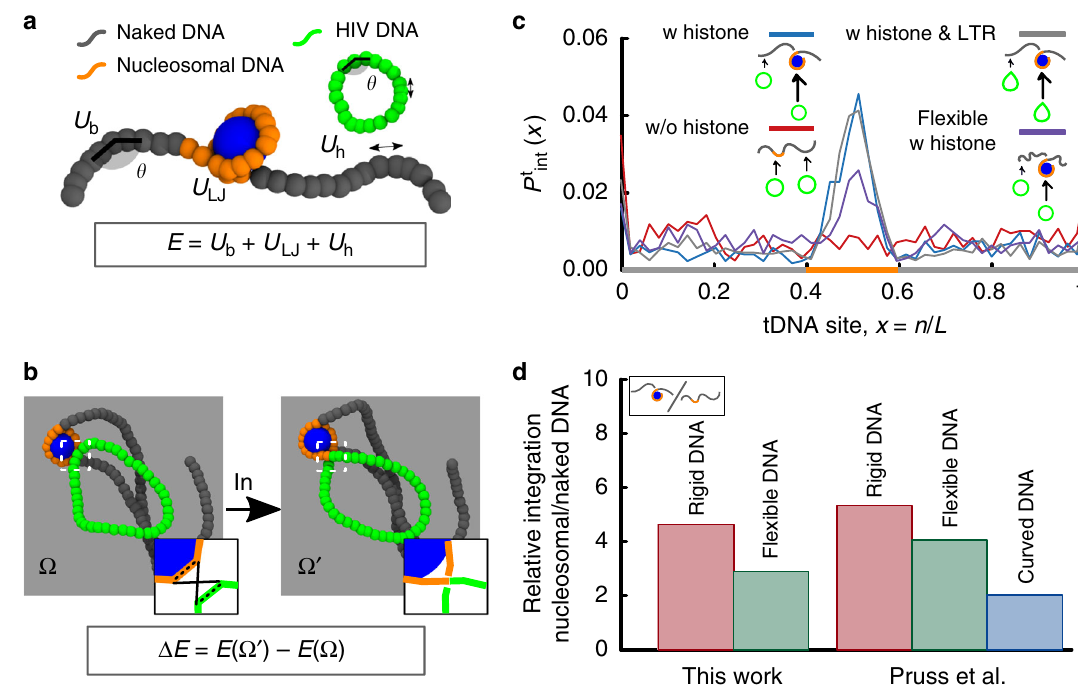
Fig. 1 DNA elasticity biases HIV integration in nucleosomes. a Model for tDNA and vDNA as diffusing bead-spring polymers with bending rigidity. The potentials associated with bending ( U b ( θ )), steric/attractive interactions ( U LJ ) and stretching of the bonds ( U h ) contribute to the energy E of a given con fi guration. b A quasi-equilibrium stochastic integration event takes into account the energy before and after the integration event ( E ( Ω ) and E ( Ω ′ ), respectively) to determine a successful integration probability p = min{exp( − Δ E / k B T ), 1}. c The integration pro fi le P int ( x ) as a function of the relative tDNA site, x = n / L , displays a ~4-fold enhancement in the region wrapped around the histone-like protein. The same behaviour is observed when a kinked site (corresponding to the intasome fl anked by LTR) is included in the vDNA. Considering fl exible tDNA ( l p = 30 nm) weakens this preference. d Direct quantitative comparison of relative integration enhancement with the data reported in ref. 8 . The integration pro fi les in c are averages over 1000 independent simulations and the dynamics of the simulated process can be seen in Supplementary Movies 1 and 2. Source data are provided as